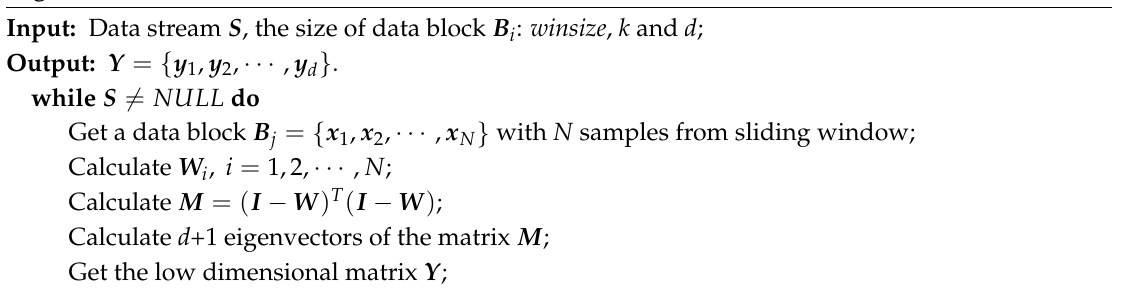
Algorithm 2 Dimension-reduction of data